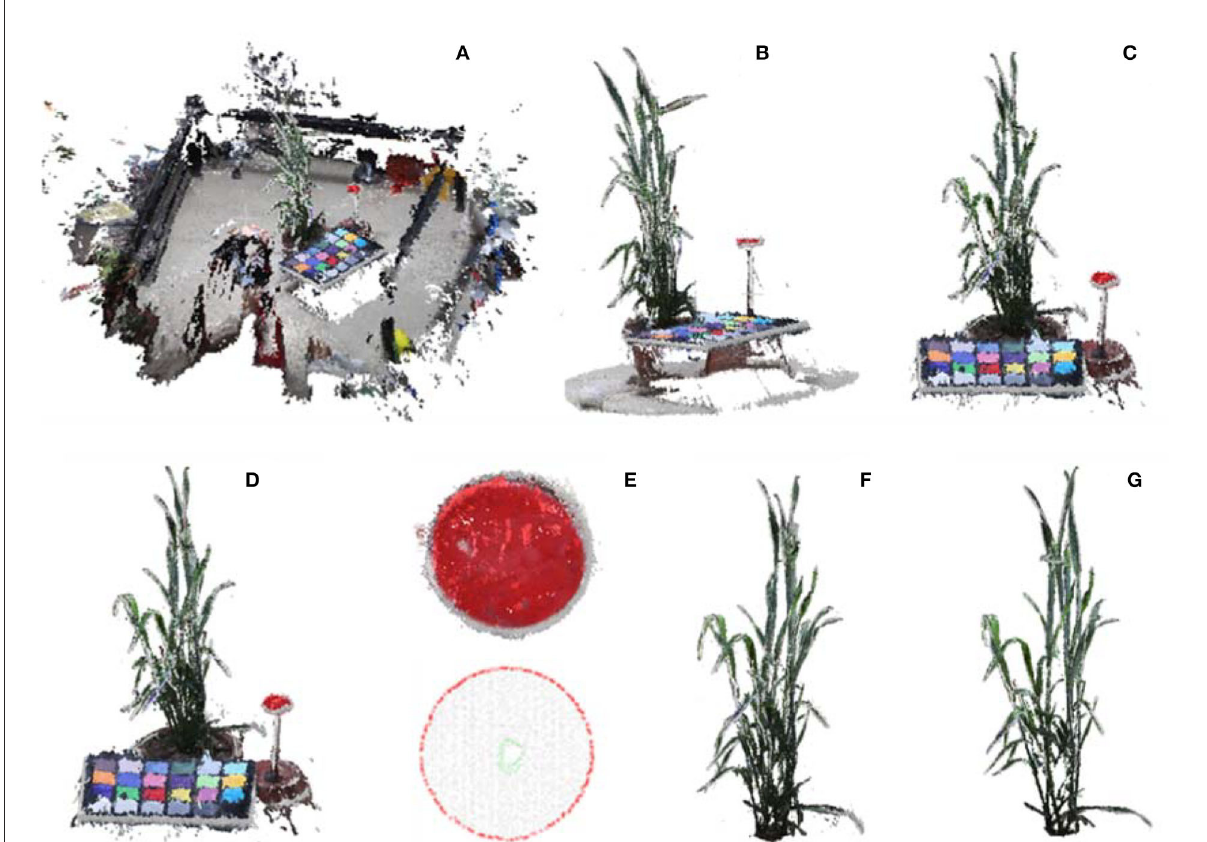
FIGURE4 Point cloud calibration and shoot segmentation. (A) Reconstructed initial point cloud of scene inside MVS-Pheno V2 platform using the acquired multi-view images. (B) Point cloud cropping via cylinder. (C) Ground point cloud removal. (D) Down sampling of shoot point cloud. (E) Marker plate extraction and radius estimation for point cloud calibration. (F) Shoot point cloud segmentation. (G) Shoot point cloud denoising.